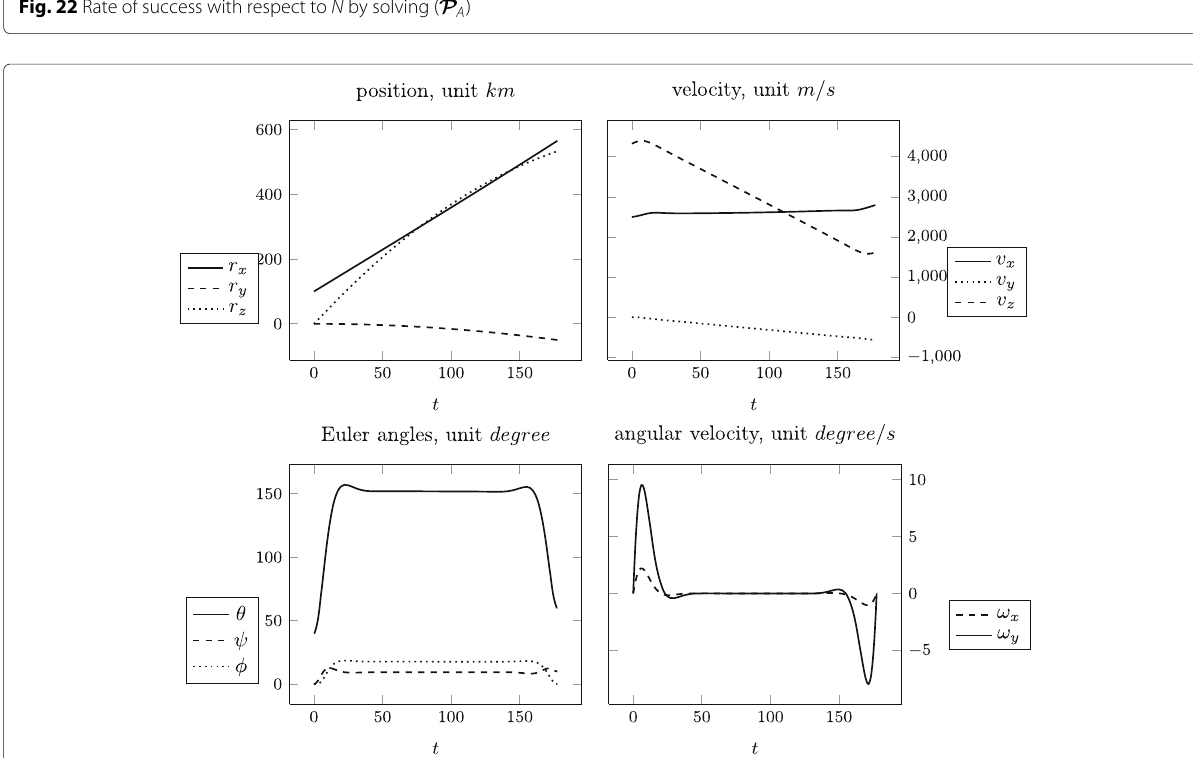
Fig. 23 Time history of state variable x ( t ) for a reorientation